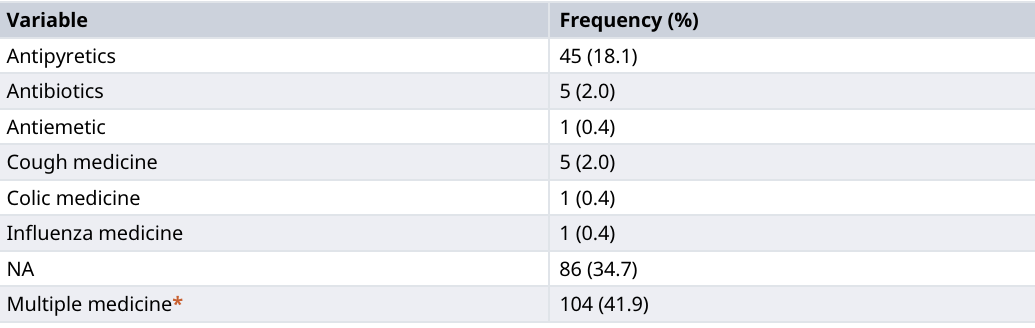
Table 5. Types of self-therapies used by parents for their children a ( N